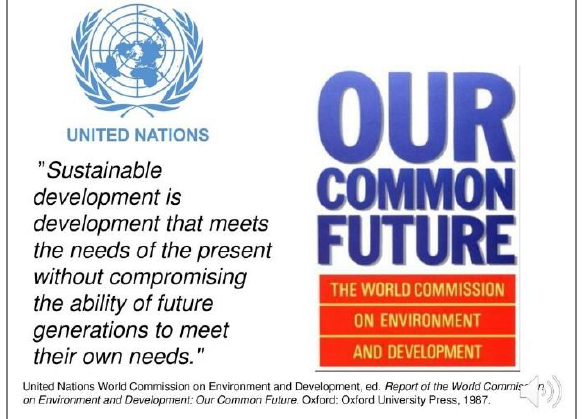
Figure 1 The Brudtland Report (United Nations World Commission,